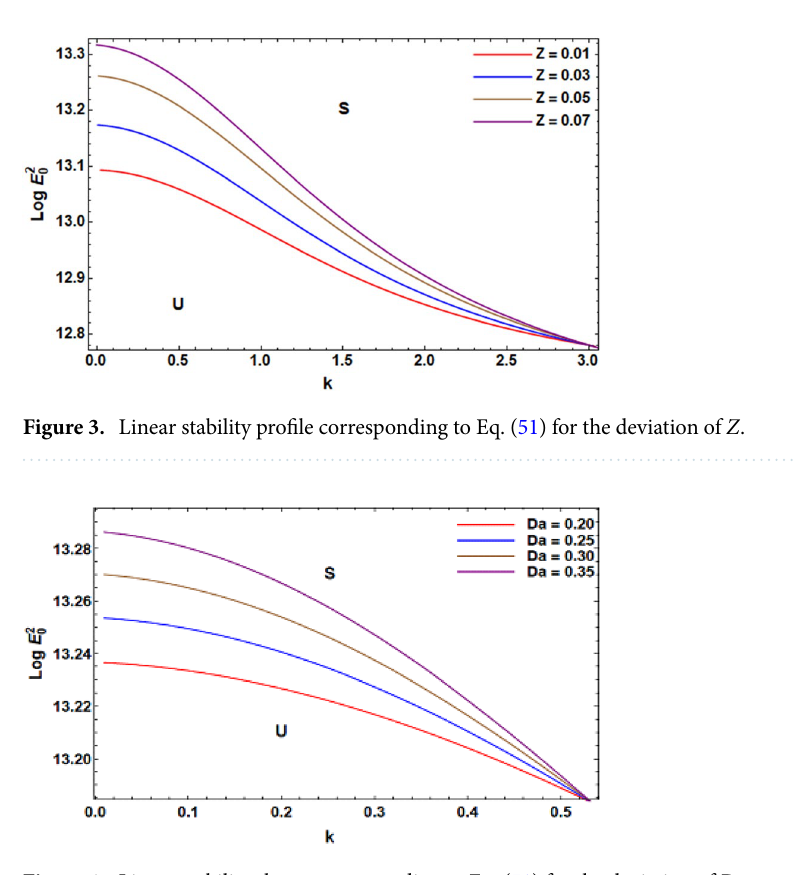
Figure 4. Linear stability shape corresponding to Eq. (51) for the deviation of Da .